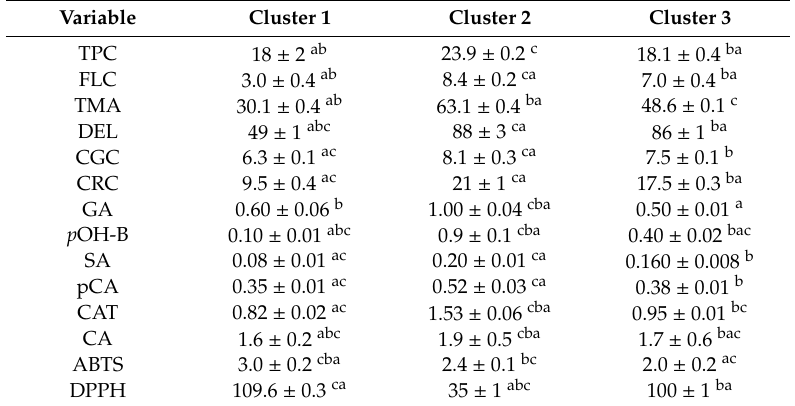
Table 2. Nonparametric analysis of functional traits of A. unedo extracts analyzed (mean values ± standard